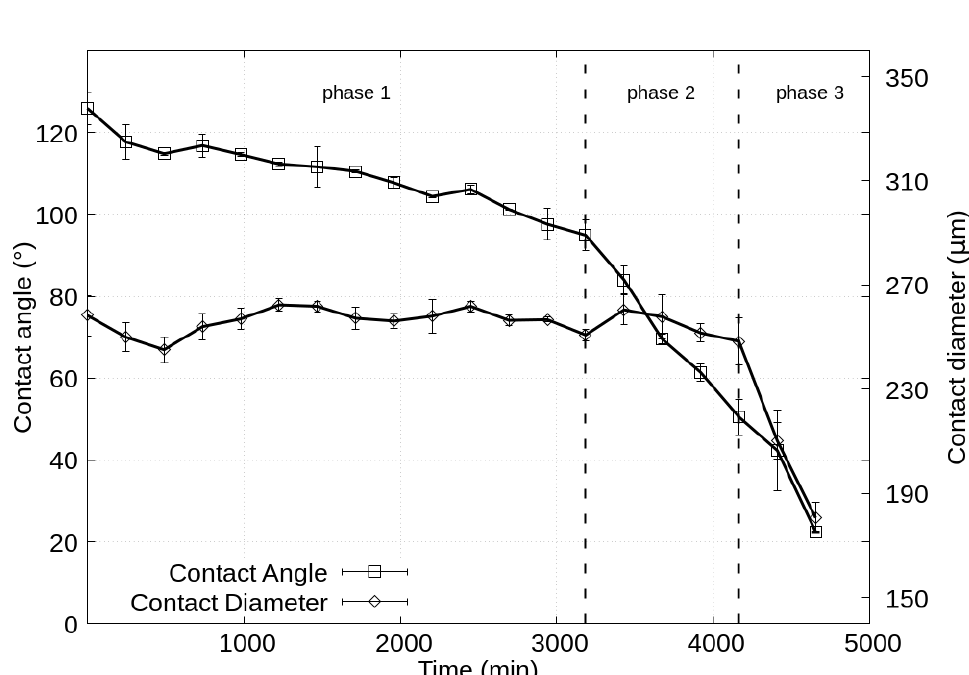
Figure 4. The time evolution of shape descriptors of a droplet imaged from a side view. Vertical lines indicate the boundary between the three different phases. See also Supplementary Video